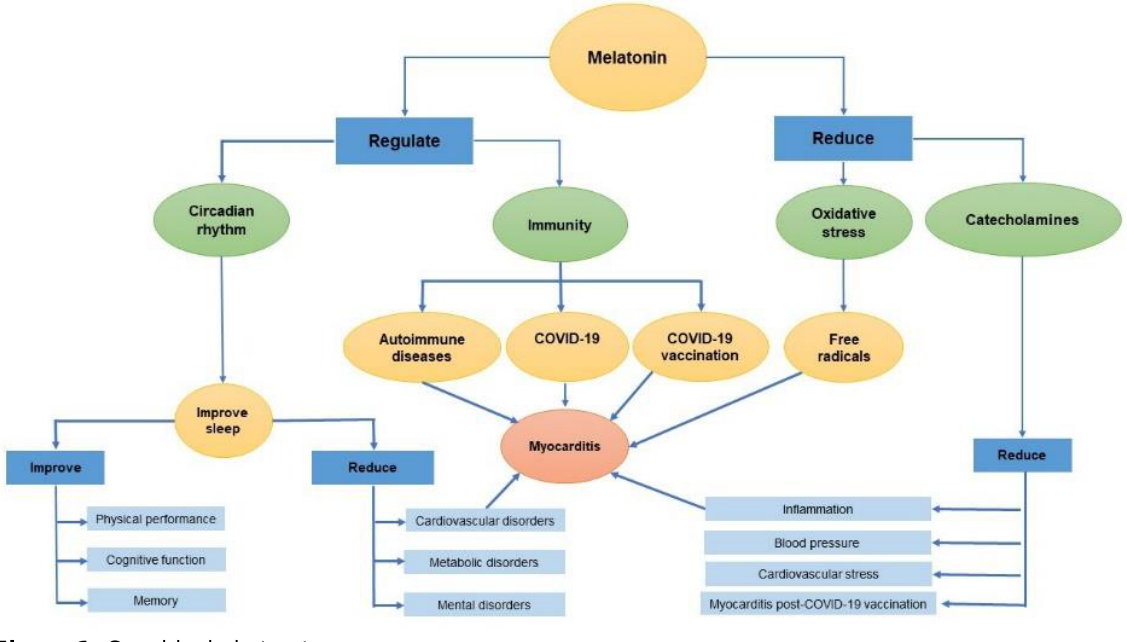
Figure 1: Graphical